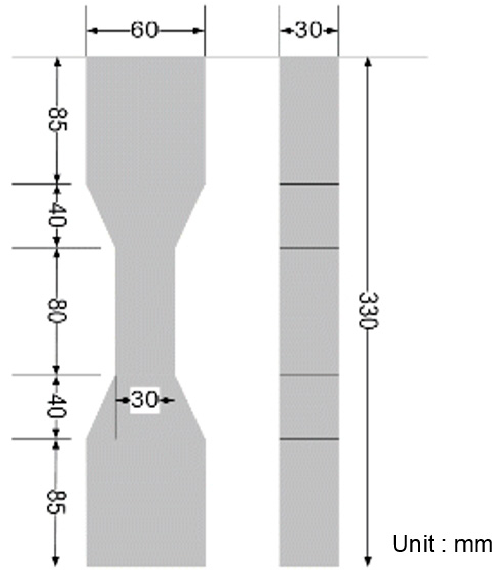
Figure 1. Dimension of ECC specimen for uniaxial tension test.